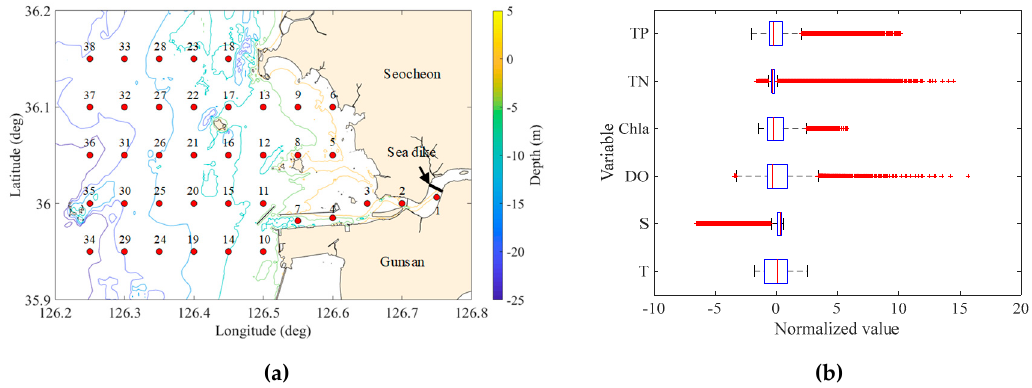
Figure A2. ( a ) The initial placement of the monitoring points and ( b ) boxplot of each variable.